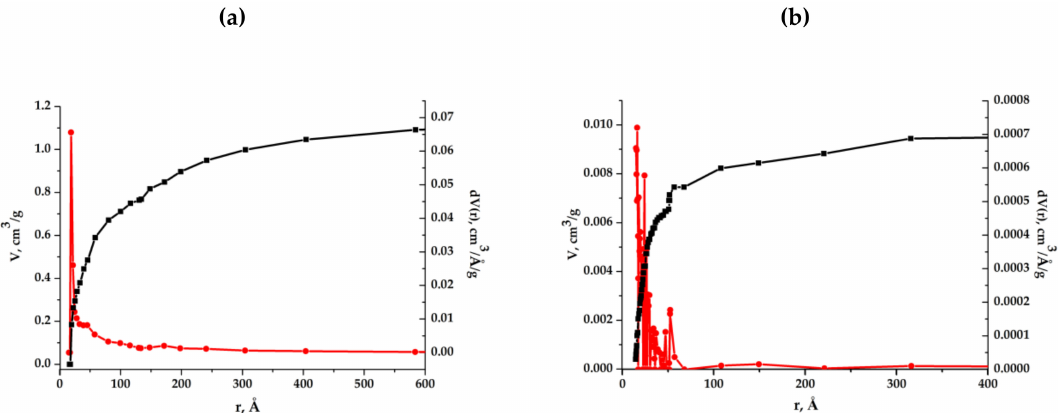
Figure 8. Specific pore volumes and size distribution for light ( a ) and dense ( b ) composite